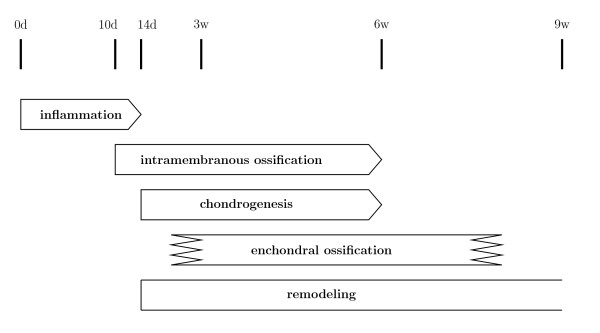
Time course of fracture healing in Ovis aries. Time line showing the central processes during fracture healing in a sheep model under standardized external fixation (mechanically uncritical). The starting time and duration of each process were estimated from histological analysis at the indicated time points. The temporal extension of the enchondral ossification phase is loosely defined with the starting and ending point probably being localized between the analyzed time points (Lienau, Schell, and Duda, unpublished data).